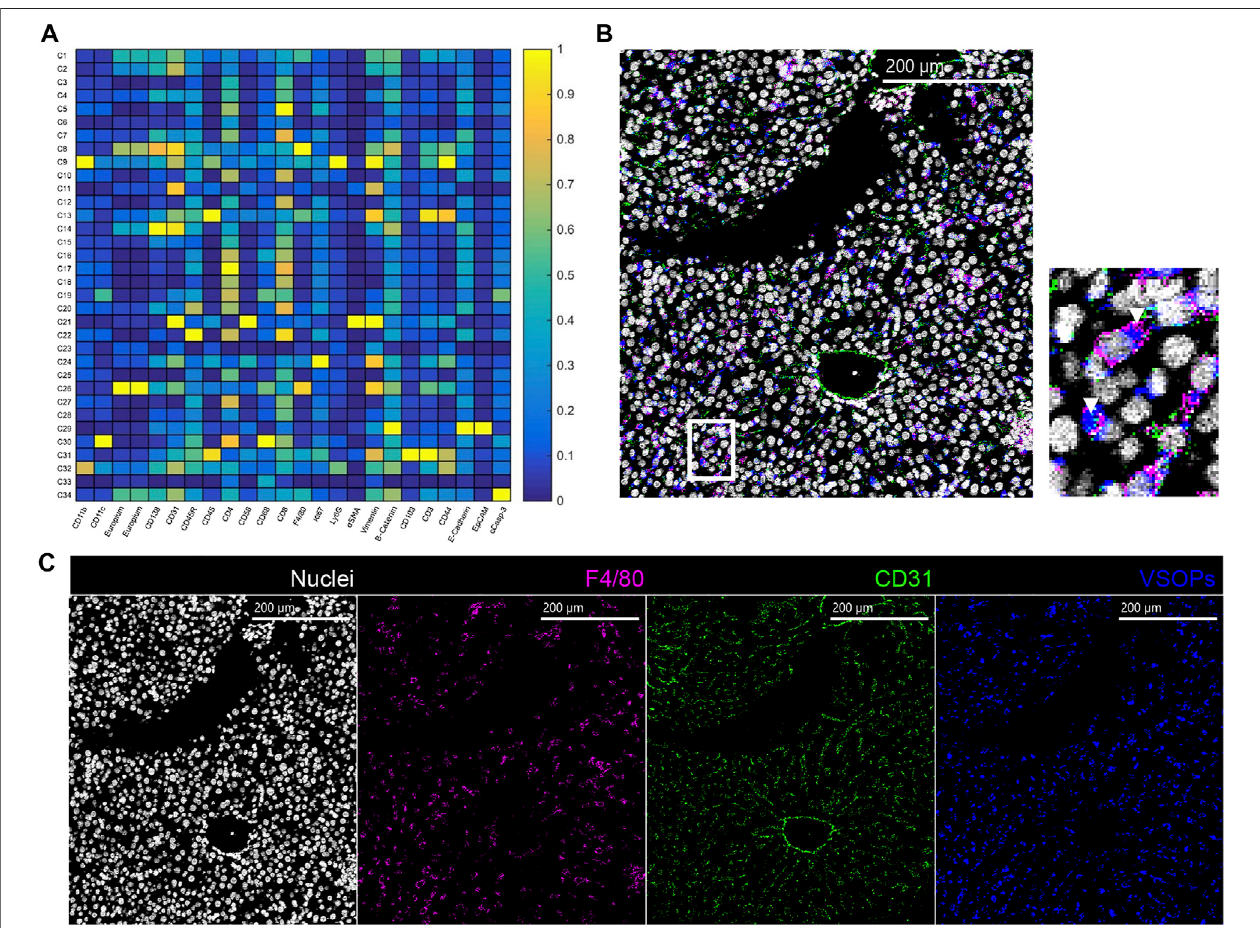
FIGURE 4 | VSOP in the liver are associated with sinusoidal macrophages. (A) Heatmap of liver tissue analysis shows co-localization of VSOPs with cluster eight und cluster 26. In representative IMC image of a transfer colitis mouse at day 40 and injected with VSOPs, nuclei are presented in white, VSOPs in blue, CD31 in green and F4/80inmagentainamerged image and azoomed in regionofthe liverwith whitearrow heads pointing at VSOP accumulation (B) .Individual images fornuclei,F4/ 80, CD31 and VSOPs (C) .